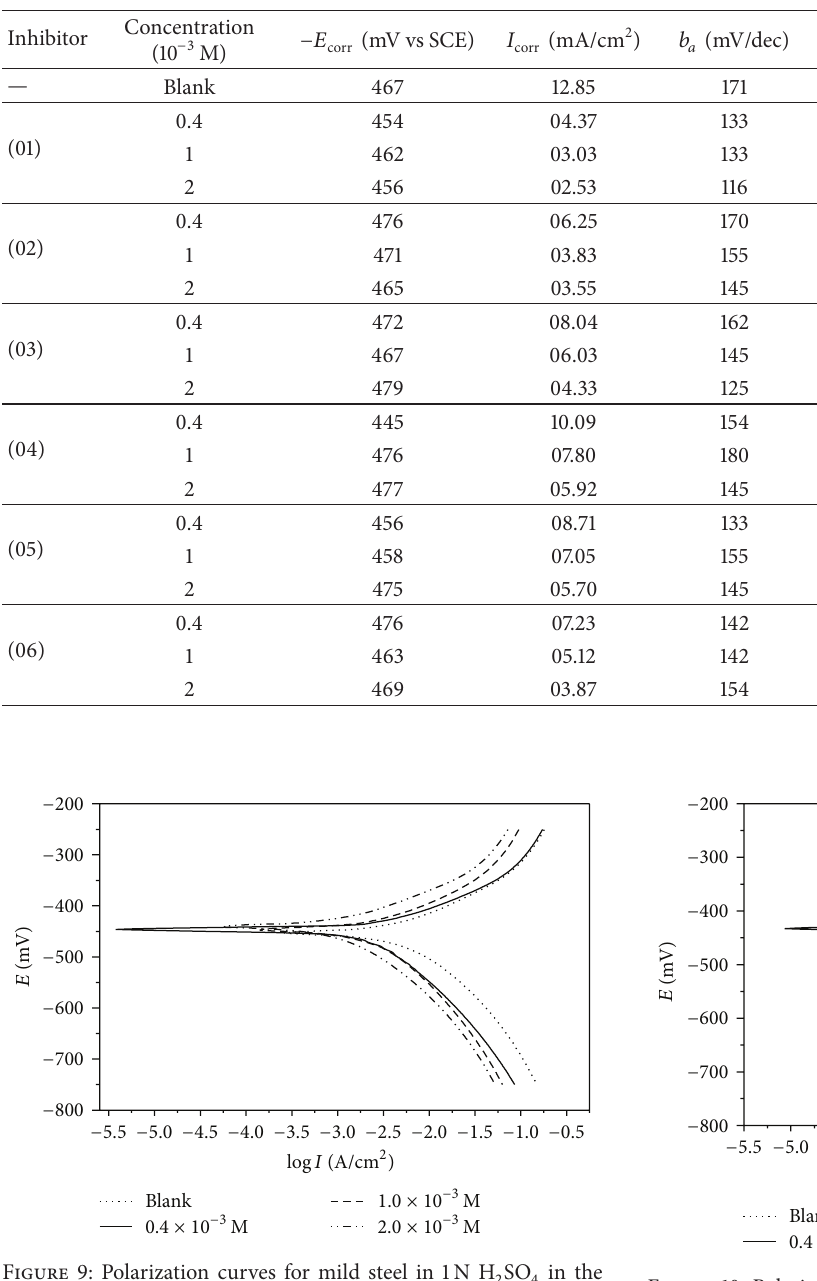
Figure 10: Polarization curves for mild steel in 1N H 2 SO 4 in the absence and presence of different concentration of inhibitor